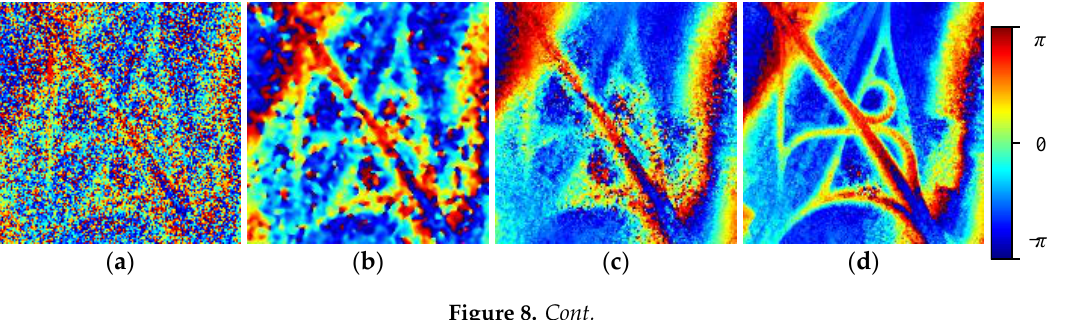
Figure 7. Comparison of the results of three phase filtering methods: ( a ) original interferogram, ( b ) Lee method, ( c ) Goldstein method, and ( d ) our method.